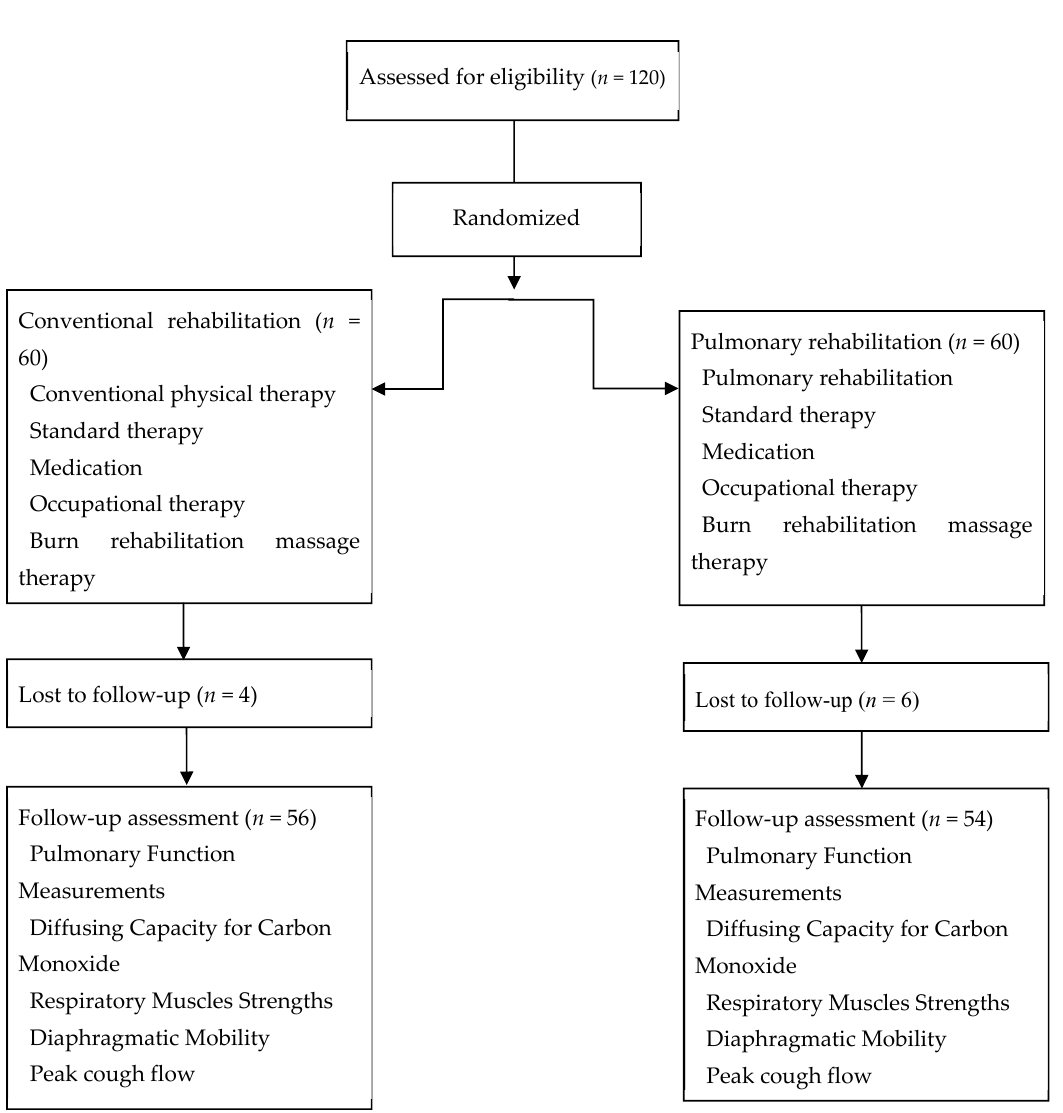
Figure 2. Diagram for subject enrollment, allocation and follow up.